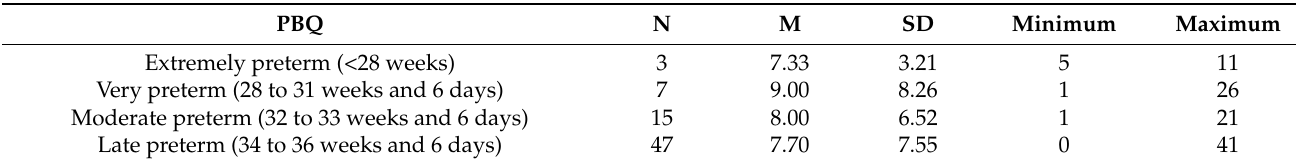
Table 2. Mean results of PBQ in terms of the sub-categories of preterm birth with regard to the cut-offs of gestational age. PBQ N M SD Minimum Maximum Extremely preterm (<28